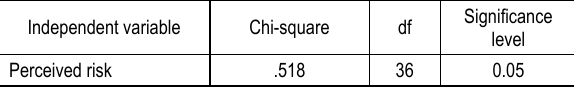
Table 7. The results of test of the relationship between perceived risk of solar water heater and